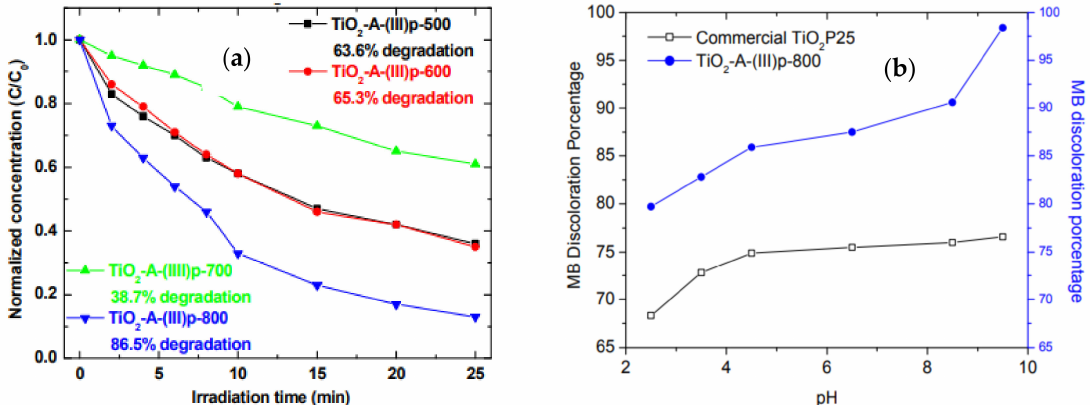
Figure 20. ( a ) Normalized concentration changing of MB as a function of time for all TiO 2 photocata- lyst obtained by precursors (Chitosan) • (TiOSO 4 ) at different temperatures. ( b ) Effect of pH on MB (1 × 10 − 5 M) discoloration using our best TiO 2 .